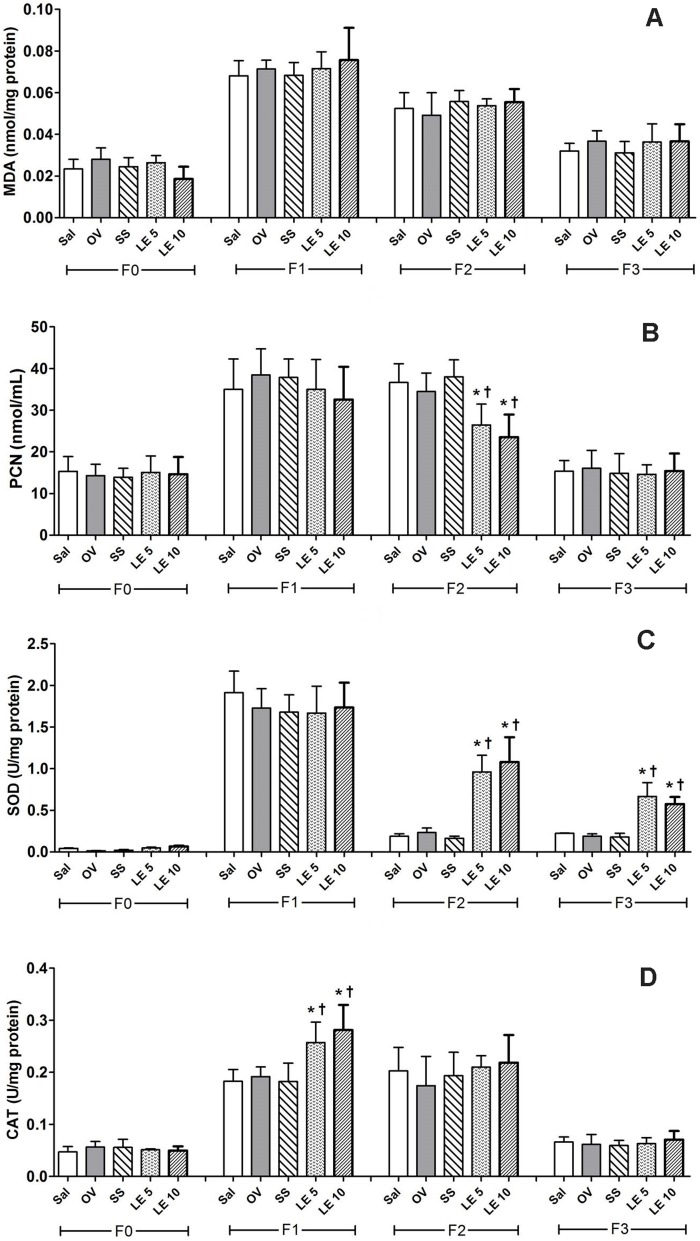
Levels of malondialdehyde (MDA) (A), carbonylated proteins (PCN) (B), superoxide dismutase (SOD) (C) and catalase (CAT) (D) in scar tissue from rats treated with Strychnos pseudoquina extract. F0: untreated normal tissue, F1: treated tissue after seven days, F2: treated tissue, after 14 days, F3: tissue treated after 21 days. Sal: saline solution, OV: vehicle, SS: silver sulfadiazine, LE 5: S. pseudoquina 5%; LE 10: S. pseudoquina 10%. Data represented as mean ± SD. *† p<0.05, statistical difference between treatments: * vs. Sal and OV, *† vs. Sal, OV and SS (Kruskal-Wallis test).